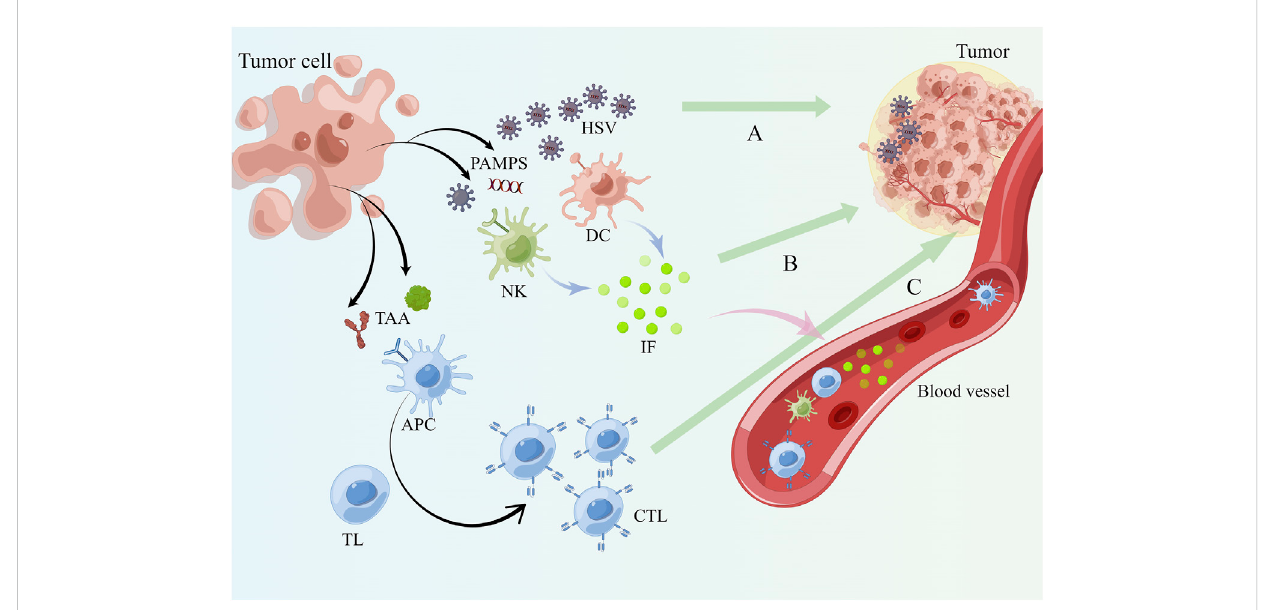
FIGURE 3 HSVremodelstheTMEandinducessystemic anti-tumor immunity. (A) After thetumorcellsare lysed,PAMPS arereleasedand themature HSVvirus continuestoinfectothertumorcellsintheTME. (B) PAMPSarerecognizedbyimmunecellsubsetspresentintheTMEsuchasDC,NKandAPCrelyingon PRRwhichsecreteimmunein fl ammatoryfactorslikeIFN- γ ,IL-6andIL-12. (C) APCphagocytoseTAAandPAMPSandpresentantigenstoTlymphocytes, activating them to become cytotoxic T lymphocytes to complete the adaptive immunity against tumor cells. Blood circulation allows mature progeny viruses, immune cells and immune molecules to reach the whole body and a systemic anti-tumor immune response